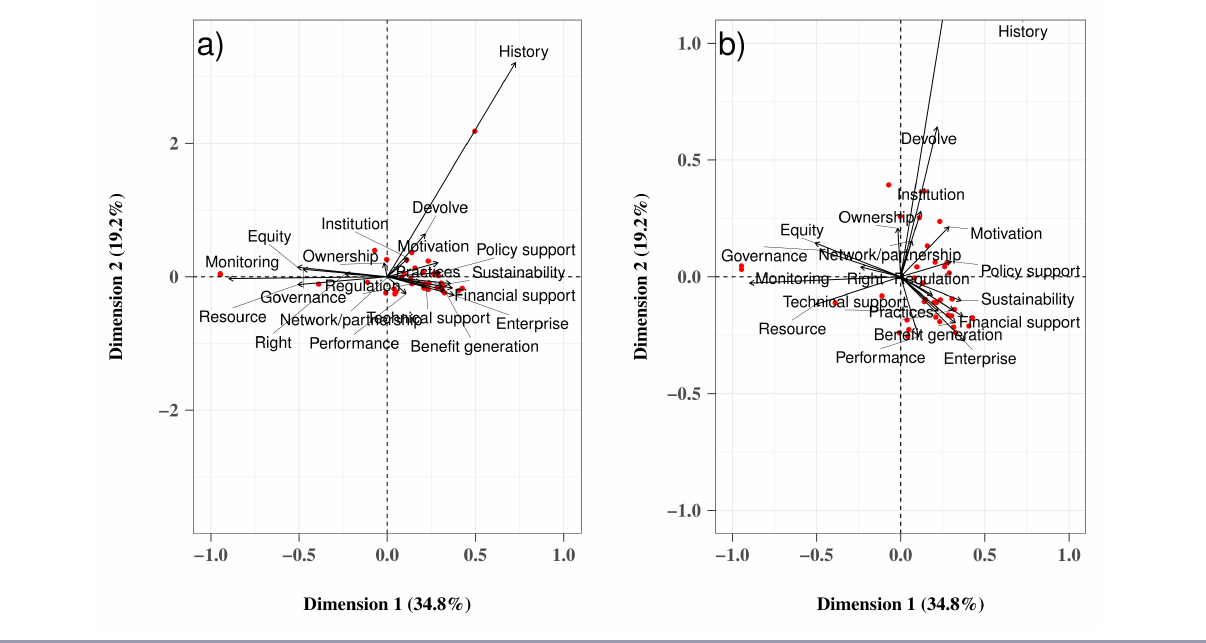
Fig. 5 . Biplot of the distribution of the main enablers according to correspondence analysis; a) full data set, b) truncated to better show points other than